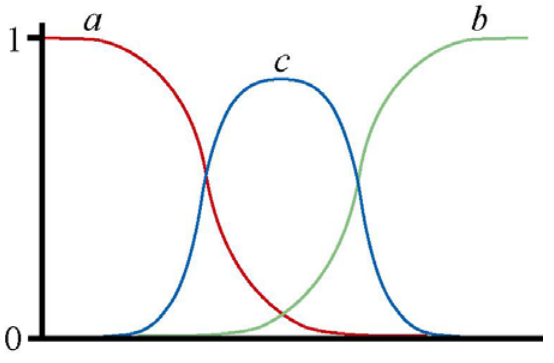
Figure 2. Diagram illustrating staggered clines within a hybrid zone relating to alleles at one locus. The x axis represents geographic distance along a transect across the hybrid zone and the y axis represents frequency. One hybridising race is characterised by allele a , and the other by allele b . A new allele ( c ) arises within the hybrid zone and its high frequency causes staggering of the clines for the race-specific